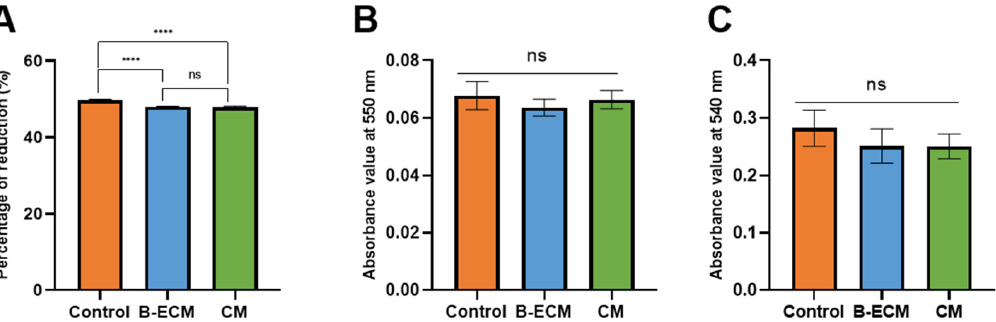
Figure 5. Macrophage response assay assessed by Alamar blue assay ( A ), NBT test ( B ) and NR test ( C ) ( n = 4) when RAW cells were cultured in SM (control) with digested B-ECM or CM with ns being no significant and **** p ≤ 0.0001.